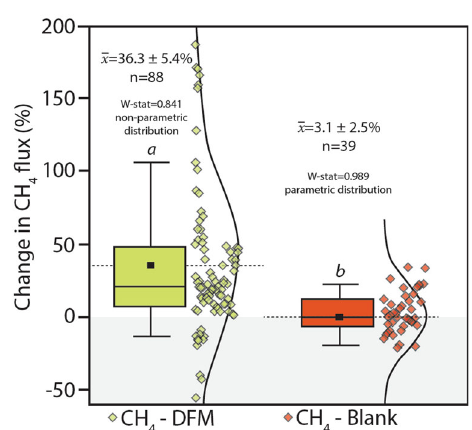
Fig. 3 Summary of in situ methanotroph (MOB) inhibitor tests conducted using di fl uoromethane (DFM) on M. quinquenervia bark revealing the mostly positive % increase in methane fl uxes ~1 h after the addition of DFM and non-parametric distribution (Shapiro – Wilk, W -stat = 0.841). The blank replicates (i.e. repeated chamber measurements after ~1 h, but no DFM addition) showed no change in mean methane fl uxes (3.1 ± 2.5%) and normal distribution (Shapiro – Wilk, W -stat = 0.989). There were signi fi cant differences between treatments a and b (ANOVA on-ranks, p < 0.001). Note: The box represents the 25 – 75 percentile, error bars 1 – 99 percentile, the solid horizontal line is the median, dashed line and small square = mean ( x ̅ ) and the curved line and scatter plots show the data